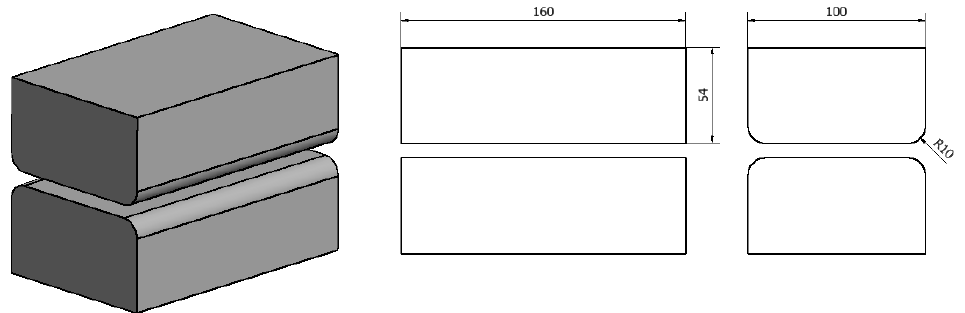
Figure 3. Shape and dimensions of flat dies used for AZ91 magnesium alloy forging.